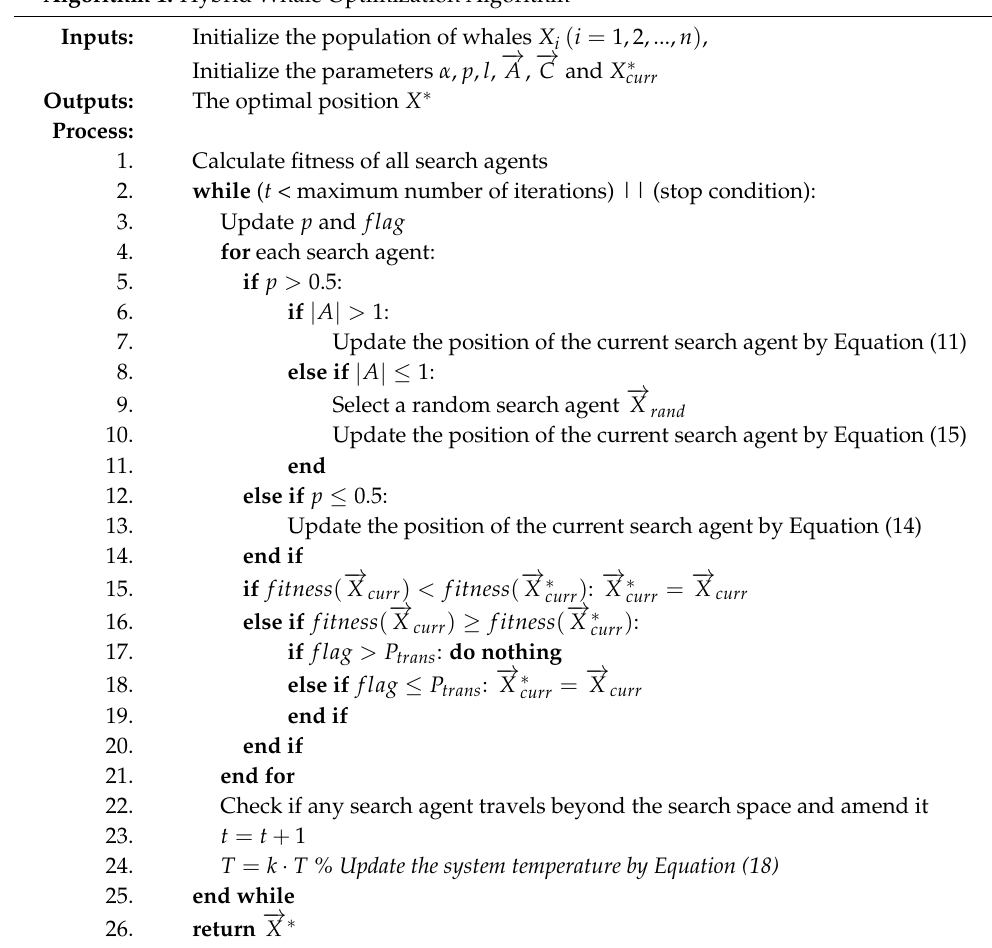
Algorithm 1: Hybrid Whale Optimization